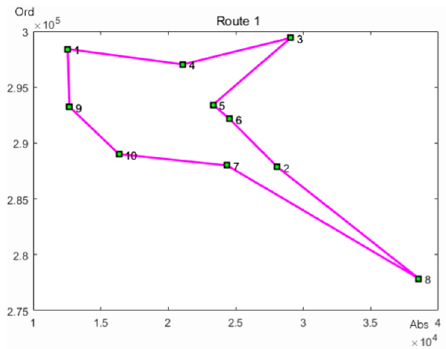
Figure 2. Delivery order of first courier.